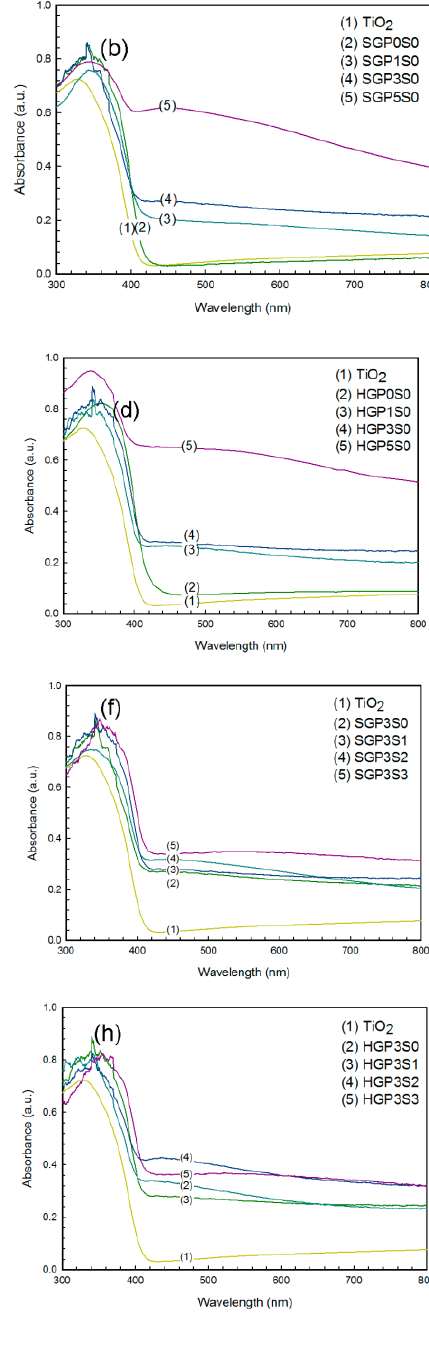
Figure 2. The UV-Vis absorption spectra of immobilized photocatalysts. (a)-(d) Effect of PANi on SCPS, SGPS, HCPS, and HGPS photocatalysts (no SDS ); (e)-(h) Effect of SDS on SCP3S, SGP3S, SGPS, HCPS, and HGPS photocatalysts (no no sodium dodecyl sulfate (SDS)); ( e – h ) Effect of SDS on HCP3S, and HGP3S photocatalysts. SCP3S, SGP3S, HCP3S, and HGP3S